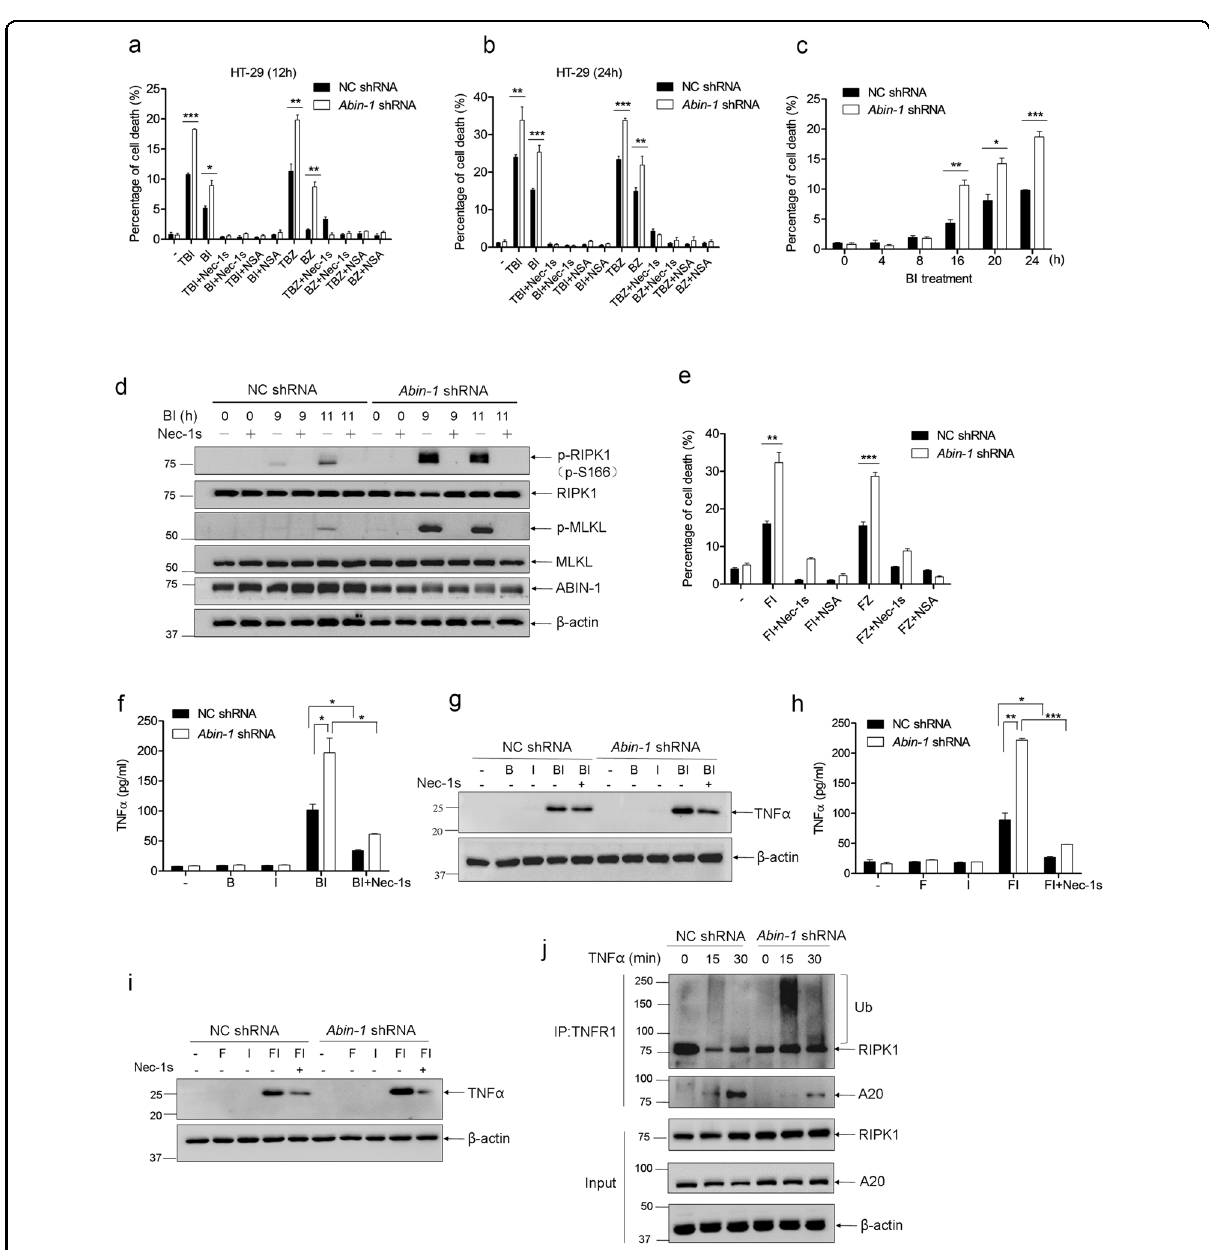
Fig. 4 ABIN-1 de fi ciency augments necroptosis in colorectal cancer cells triggered by birinapant + IDN-6556/zVAD or 5- fl uorouracil + IDN- 6556/zVAD. a, b HT-29 cells were transduced with lentivirus-based control shRNA (NC shRNA) or Abin-1 shRNA and screened with puromycin for 5 days. Then, cells were treated with TNF α + birinapant + IDN-6556 (TBI), birinapant + IDN-6556 (BI), TNF α + birinapant + zVAD (TBZ), or birinapant + zVAD (BZ) for 12 h or 24 h in the presence or absence of Nec-1s or NSA. Drug treatments for 12 h ( a ); Drug treatments for 24 h ( b ); c HT-29 NC shRNA and Abin-1 shRNA cells were treated with BI for 0, 4, 8, 16, 20, or 24 h, and cell deaths were measured by ToxiLight assay. d HT-29 NC shRNA and Abin-1 shRNA cells were treated with BI for 9 h or 11 h in the presence or absence of Nec-1s. Cell lysates were detected with p-RIPK1, RIPK1, p- MLKL, MLKL, and ABIN-1 by western blot. e HT-29 NC shRNA and Abin-1 shRNA cells were treated with 5- fl uorouracil + IDN-6556 (FI) or 5- fl uorouracil + zVAD (FZ) for 36 h in the presence or absence of Nec-1s or NSA. f , g HT-29 NC shRNA and Abin-1 shRNA cells were treated with birinapant (B), IDN- 6556 (I), BI, or BI + Nec-1s for 12 h, and supernatants were collected for ELISA analysis of TNF ( f ), and cells were lysed for western blot analysis of TNF ( g ). h , i HT-29 NC shRNA and Abin-1 shRNA cells were treated with 5- fl uorouracil (F), I, FI, or FI + Nec-1s for 36 h, and supernatants were collected for ELISA analysis of TNF ( h ) and cells were lysed for western blot analysis of TNF ( i ). j HT-29 NC shRNA and Abin-1 shRNA cells were treated with TNF for 0, 15, or 30 min and then immunoprecipitated with TNFR1 antibody, followed by western blot analysis for RIPK1 and A20. TNF, 10 ng/ml for cell death and 50ng/ml for IP; birinapant, 100nM; 5-FU, 250 μ M; zVAD, 20 μ M; Nec-1s, 10 μ M; IDN-6556, 2.5 μ M; and NSA, 5 μ M. * P < 0.05, ** P < 0.01, or *** P < 0.001.